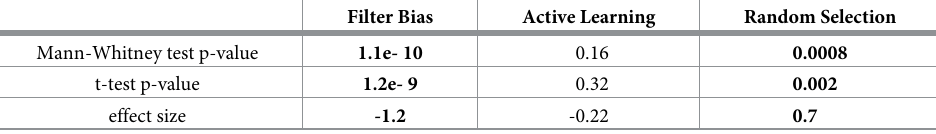
Table 10. Results of the Mann-Whitney U test and the t-test comparing the size of class-1 blind spot for the three forms of iterated algorithmic bias with class-dependent human action probability ratio 10:1. The effect size is cal- culated as ( Boundary | | )/ standard . dev . The negative effect size for filter bias shows that it increases t = 0 − Boundary t = 200 the size of the class-1-blind spot. Random selection decreases the blind spot size, while active learning does not have a significant